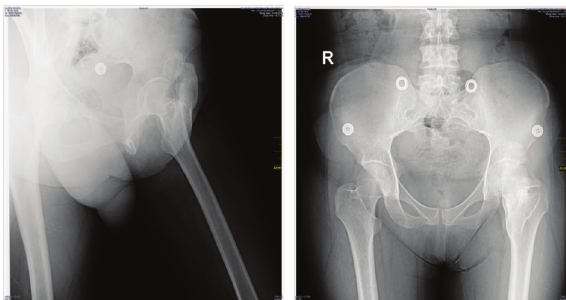
Figure 4: Preoperative radiographic evaluation MRI.